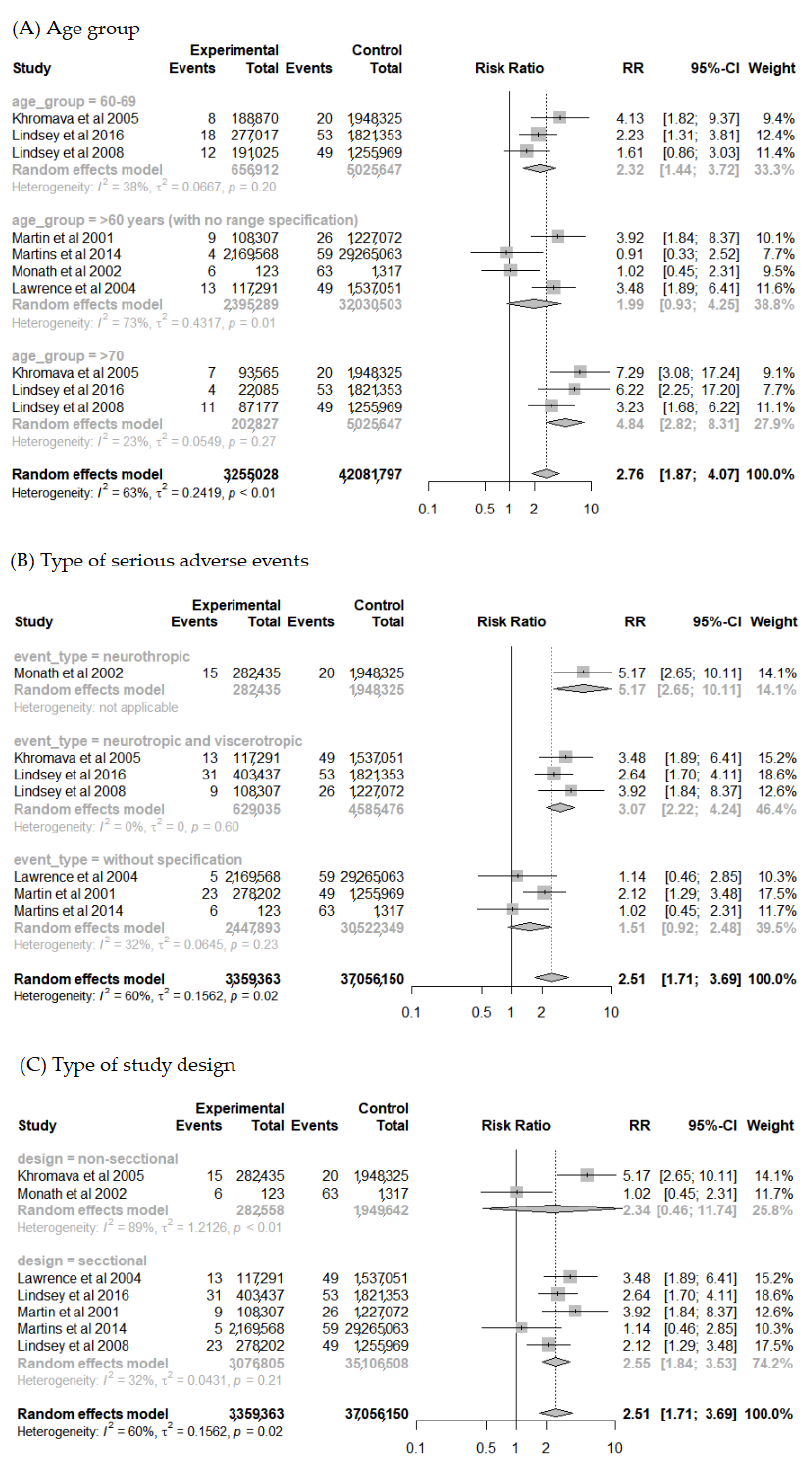
Figure 4. Forest plot of risk factor meta-analysis for adverse events after yellow fever vaccine use in participant subgroups by: ( A – C ).